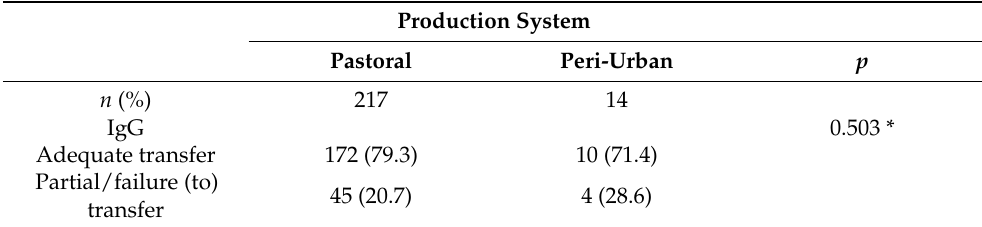
Table 9. Passive transfer of immunoglobulins (IgG).